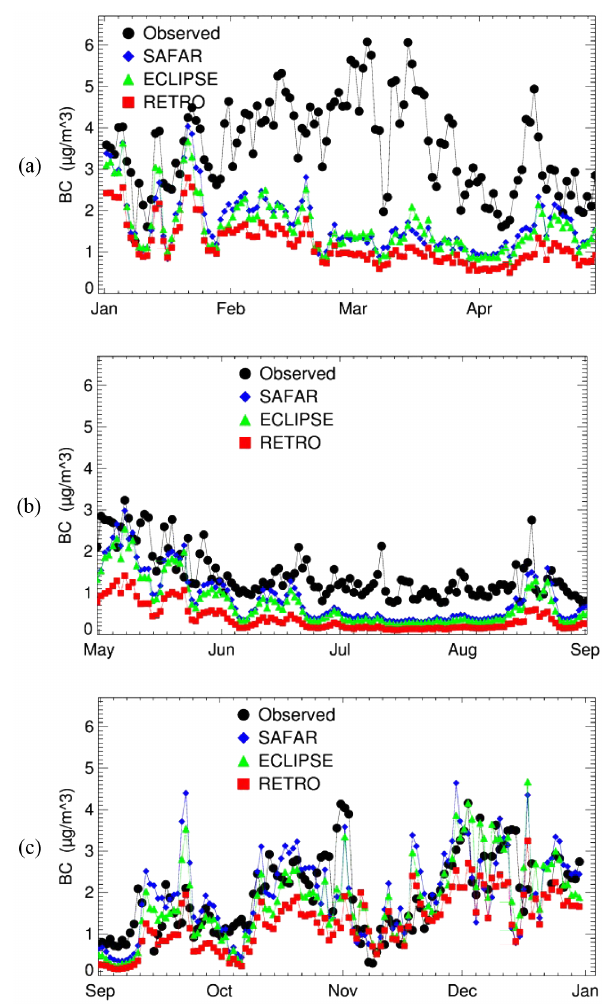
Figure 9. As Fig. 7a, but zoomed in for period (a) January to April, (b) May to August and (c) September to